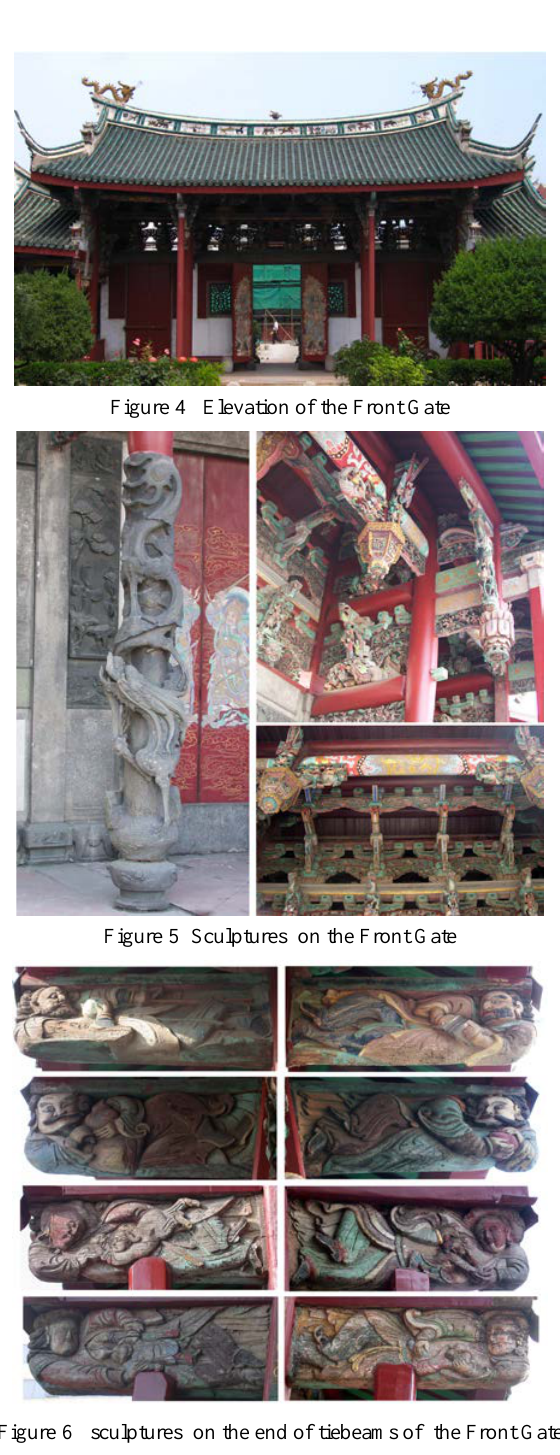
Figure 6 sculptures on the end of tiebeams of the Front Gate